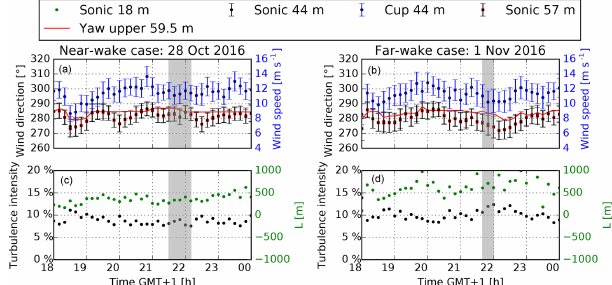
Figure 6. Atmospheric conditions during the near- and far-wake measurements as measured at the V52 met mast. (a, b) Wind direc- tion in addition to wind speed and yaw angle of the upper platform. (c, d) Total turbulence intensity and Monin–Obukhov length. Error bars represent the standard error of the mean. The gray areas depict the time of the chosen measurements.